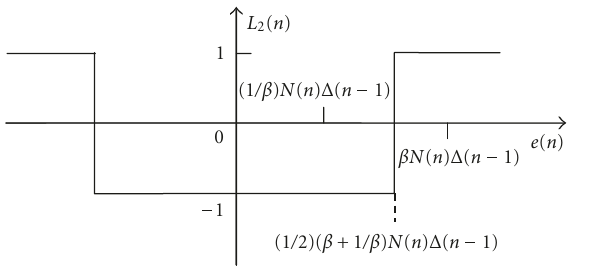
Figure 3: Input-output characteristic of the error comparator gen- erating output bit L 2 ( n ).